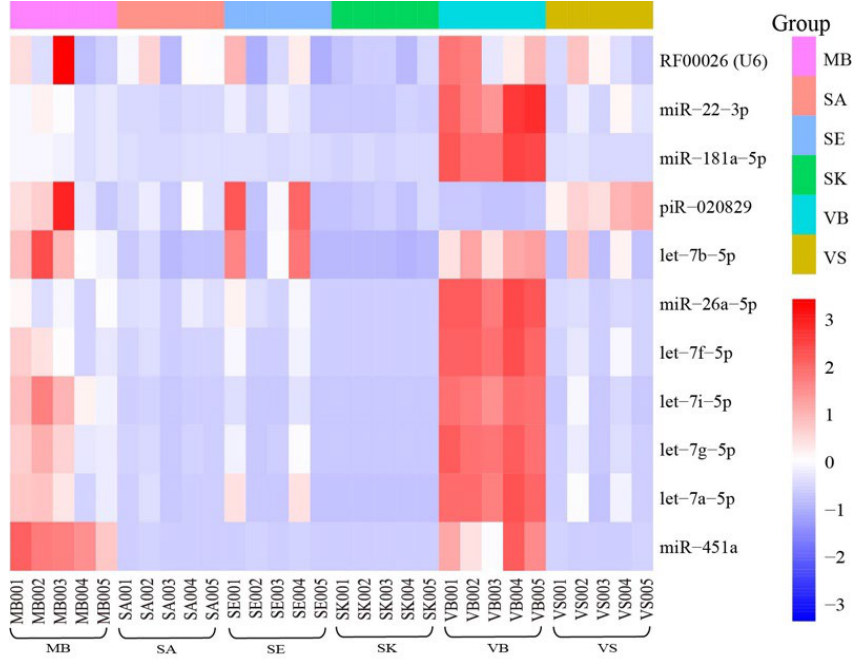
Figure 7. The expression level of the 11 reference genes screened in this